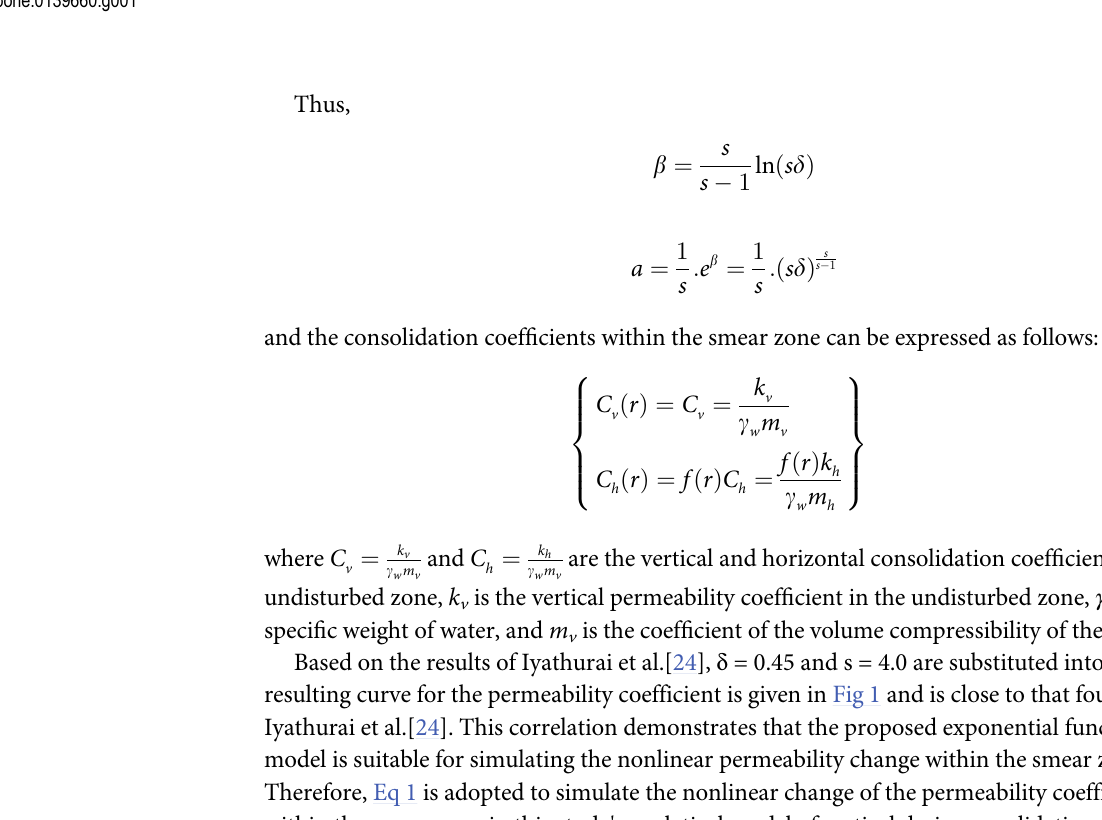
Fig 1. Smear zone permeability coefficient curve based on data from Iyathurai et al.[24] and the proposed model.